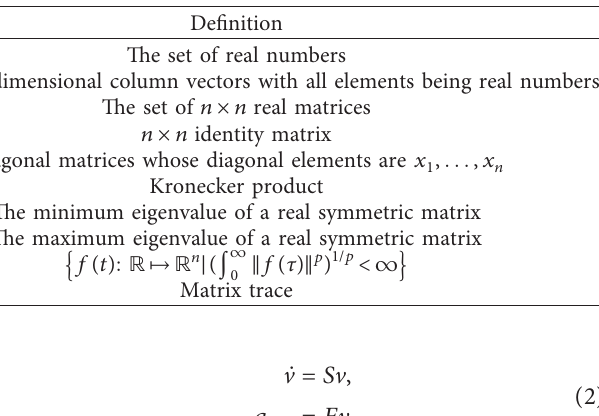
Table 1: Mathematical symbols in this